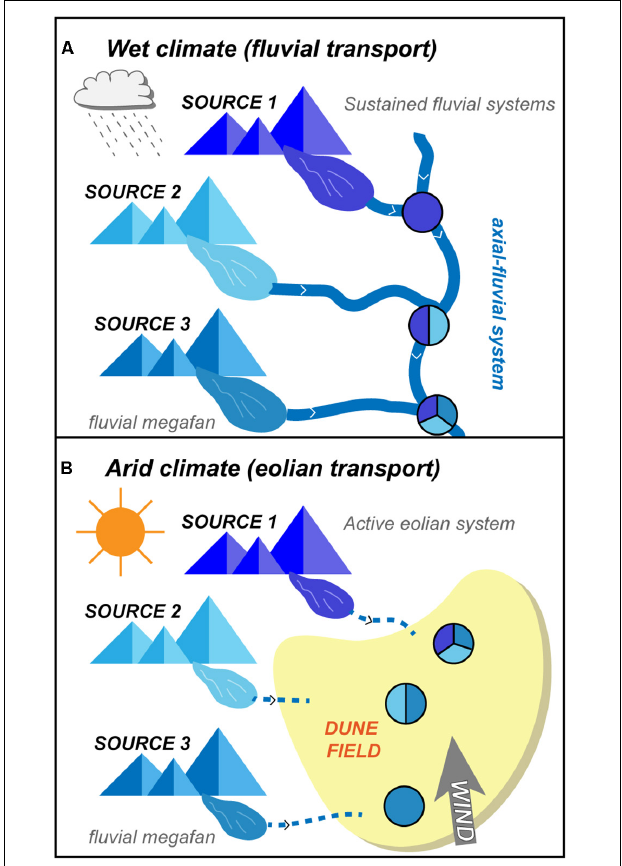
FIGURE 9 | Schematic depiction of three distinct environmental signals propagated from their source regions and transported by fluvial sediment-routing networks to distal eolian systems in an arid foreland basin. Hypothetical fluvial signatures are indicated by pie diagrams according to the respective sample location. (A) Fluvial-dominated end-member sediments contain signals dominated by the provenance of the river sources that mix southward along confluences. (B) Simplified eolian-dominated end-member where fluvial megafan deposits are reworked northward along orogen parallel wind